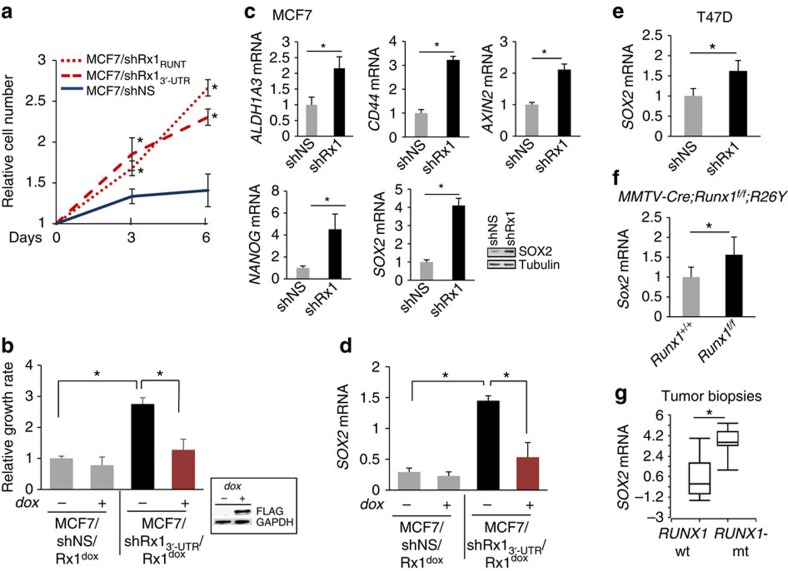
Increased proliferation and expression of stem cell markers in RUNX1-depleted mammary epithelial cells in vitro and in vivo.(a) MCF7 cells expressing nonspecific (NS) or the indicated RUNX1-targeting shRNAs were plated and their growth rate was assessed by MTT assays on days 3 and 6. (b) RUNX1 was silenced with shRx13′-UTR as in Fig. 1d,e, and was re-expressed from a dox-inducible vector as demonstrated by the western blot in the inset. Cell growth was assessed as in a and bars represent the increase in MTT values between day 3 and day 6. (c) MCF7 cells expressing a nonspecific shRNA (shNS) or shRx13′-UTR were subjected to RT–qPCR analysis of the indicated stem cell markers. Expression of Sox2 was also assessed by western blot analysis. (d) RT–qPCR analysis of SOX2 in MCF7 cells in which RUNX1 was silenced and then restored as in b. (e–g) Comparisons of SOX2 mRNA expression between (e) RUNX1-depleted versus control T47D cells; (f) mammary luminal epithelial cells from MMTV-Cre;Runxf/f;R26Y versus control MMTV-Cre;Runx1+/+;R26Y mice based on our microarray data in GSE47377 (ref. 13); (g) RUNX1-mutant (n=7) versus RUNX1-WT (n=202) breast cancer tumours based on our microarray database18, where boxes represent the 25th–75th percentile range, horizontal lines within boxes represent the median values and whiskers extend to the minimum and maximum values. Where applicable, data represent mean±s.e.m. of triplicate experiments. *P<0.05 by t-test (a–f) or by Mann–Whitney test (g).